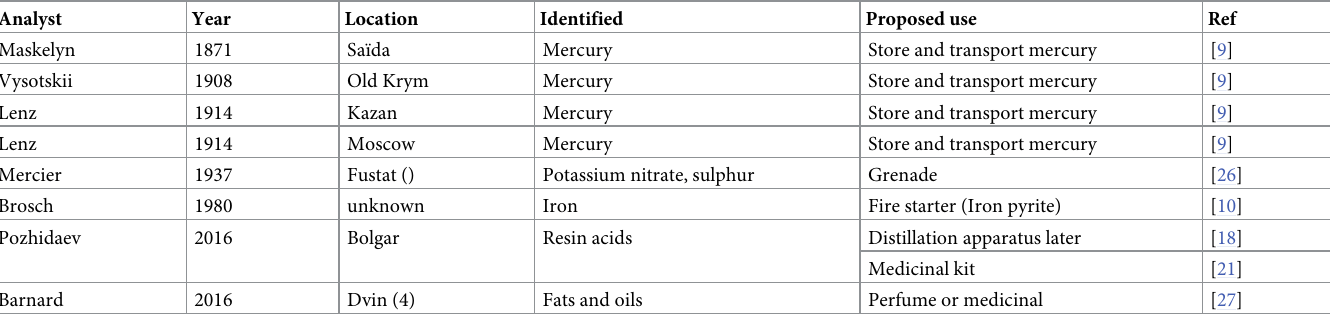
Table 2. Previous analysis and proposed uses of sphero-conical